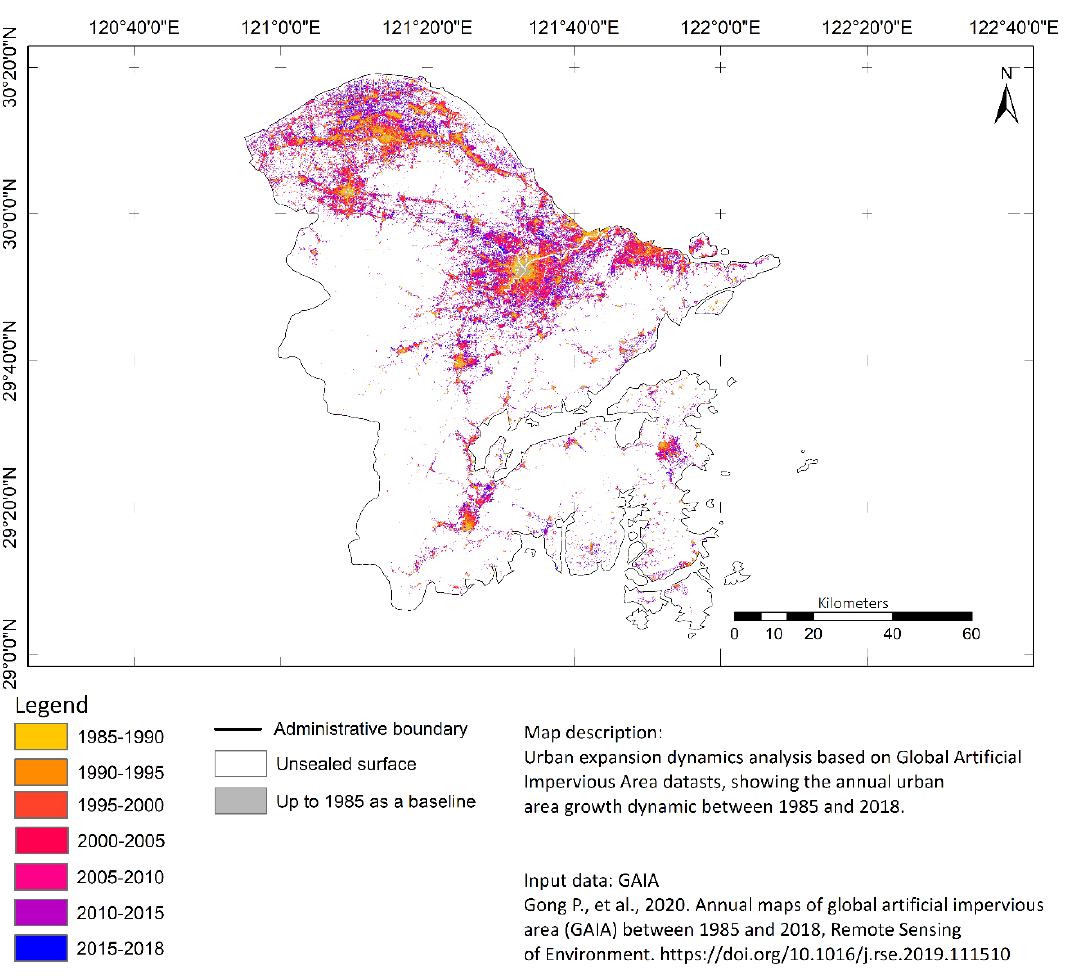
Figure A1. ( a – f ) Visualising the dynamic urban LC expansion of the study area by means of the thematic GAIA product.